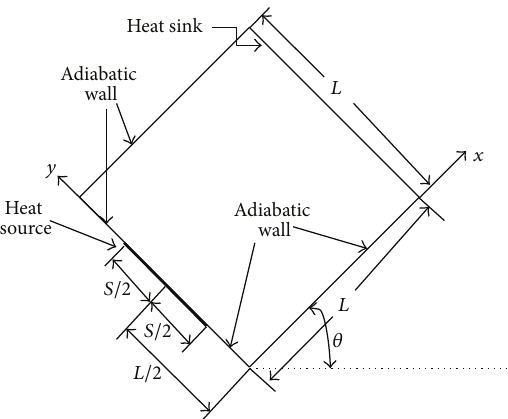
Figure 1: Schematic of the square enclosure with segmental heat